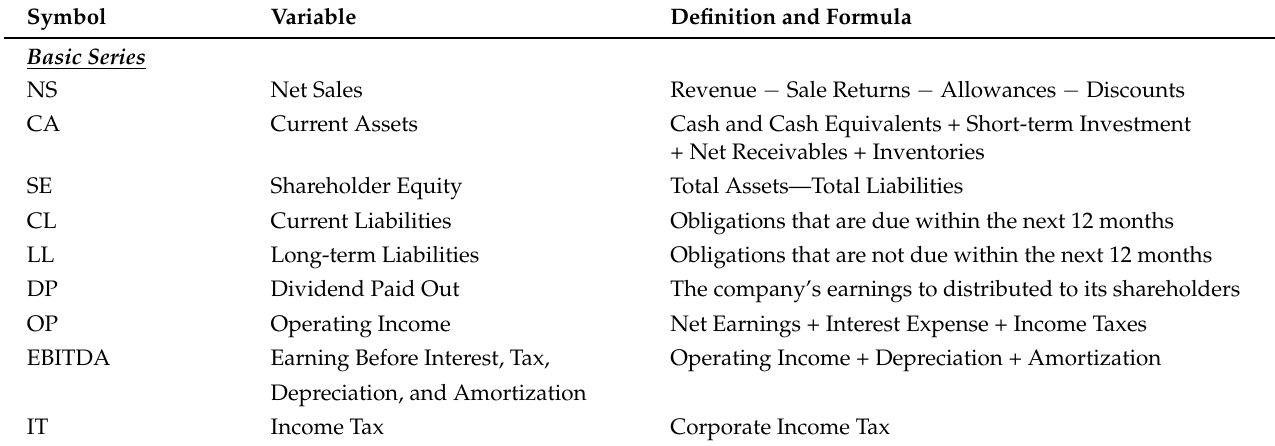
Table 3. Glossary and Definitions of Financial